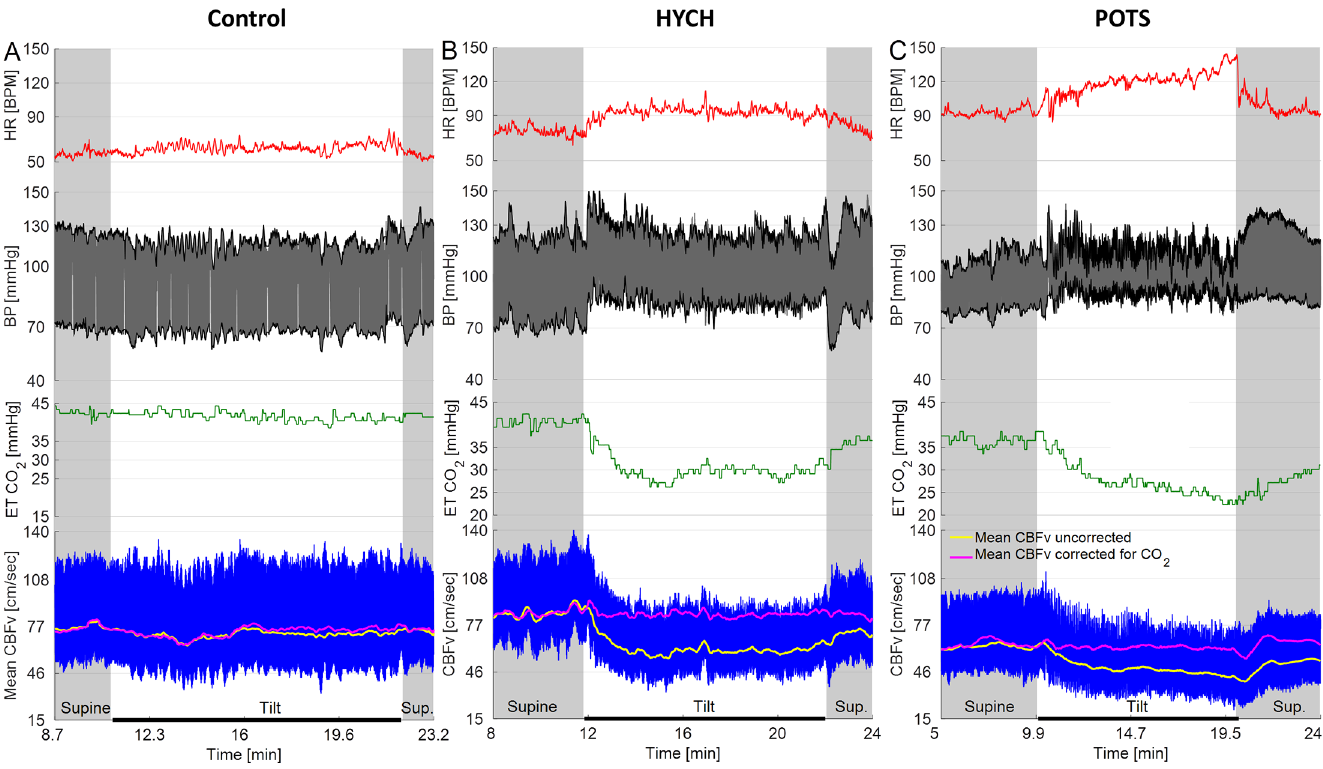
Fig 2. Representative examples of control, HYCH and